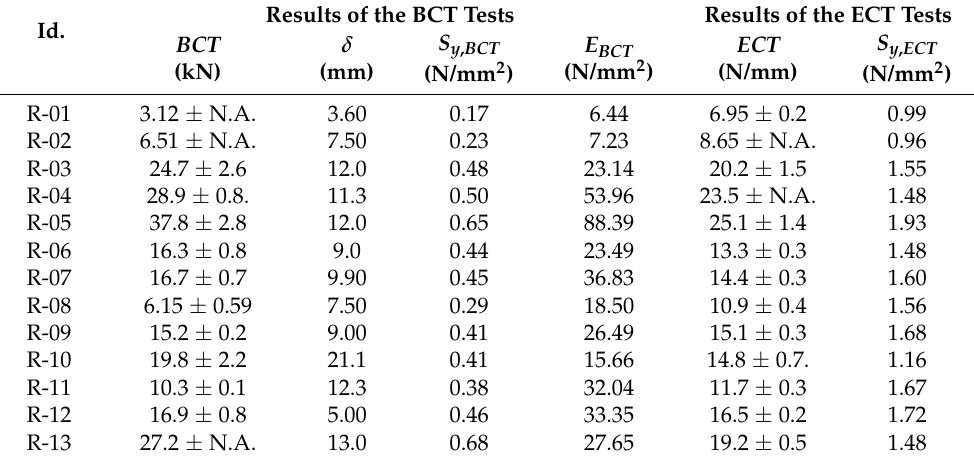
( b ) Figure 5. Force-displacement curves of the tests of the item E-09: ( a ) BCT test curves; ( b ) ECT test curves.